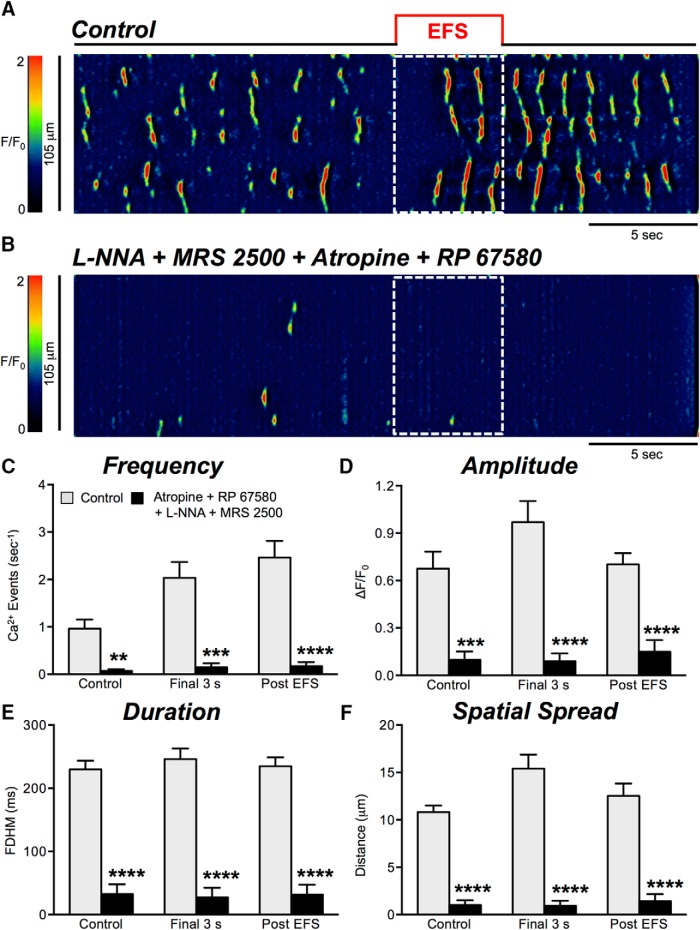
Excitatory responses to EFS are abolished by atropine and NK1 receptor antagonist. A, B, Representative ST maps showing inhibition of Ca2+ transients by atropine (1 μM) and RP 67580 (1 μM). These experiments were conducted in the presence of L-NNA (100 μM) in the presence of MRS 2500 (1 μM) during and post nerve stimulation periods (EFS at 10 Hz 5 s; indicated by the red line and dotted white box in ST maps). C–F, Summary data showing the effects of a combination of L-NNA, MRS 2500, and atropine and RP 67580 on Ca2+ transient frequency (C), amplitude (D), duration (E), and spatial spread (F) in ICC-DMP during control conditions, excitatory periods during EFS (final 3 s), and in the post-EFS period, n = 5, c = 32; ns = p > 0.05, **p < 0.01, ***p < 0.001.